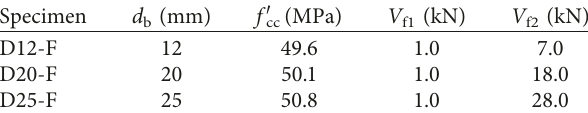
Table 2: Details of specimens subjected to fatigue